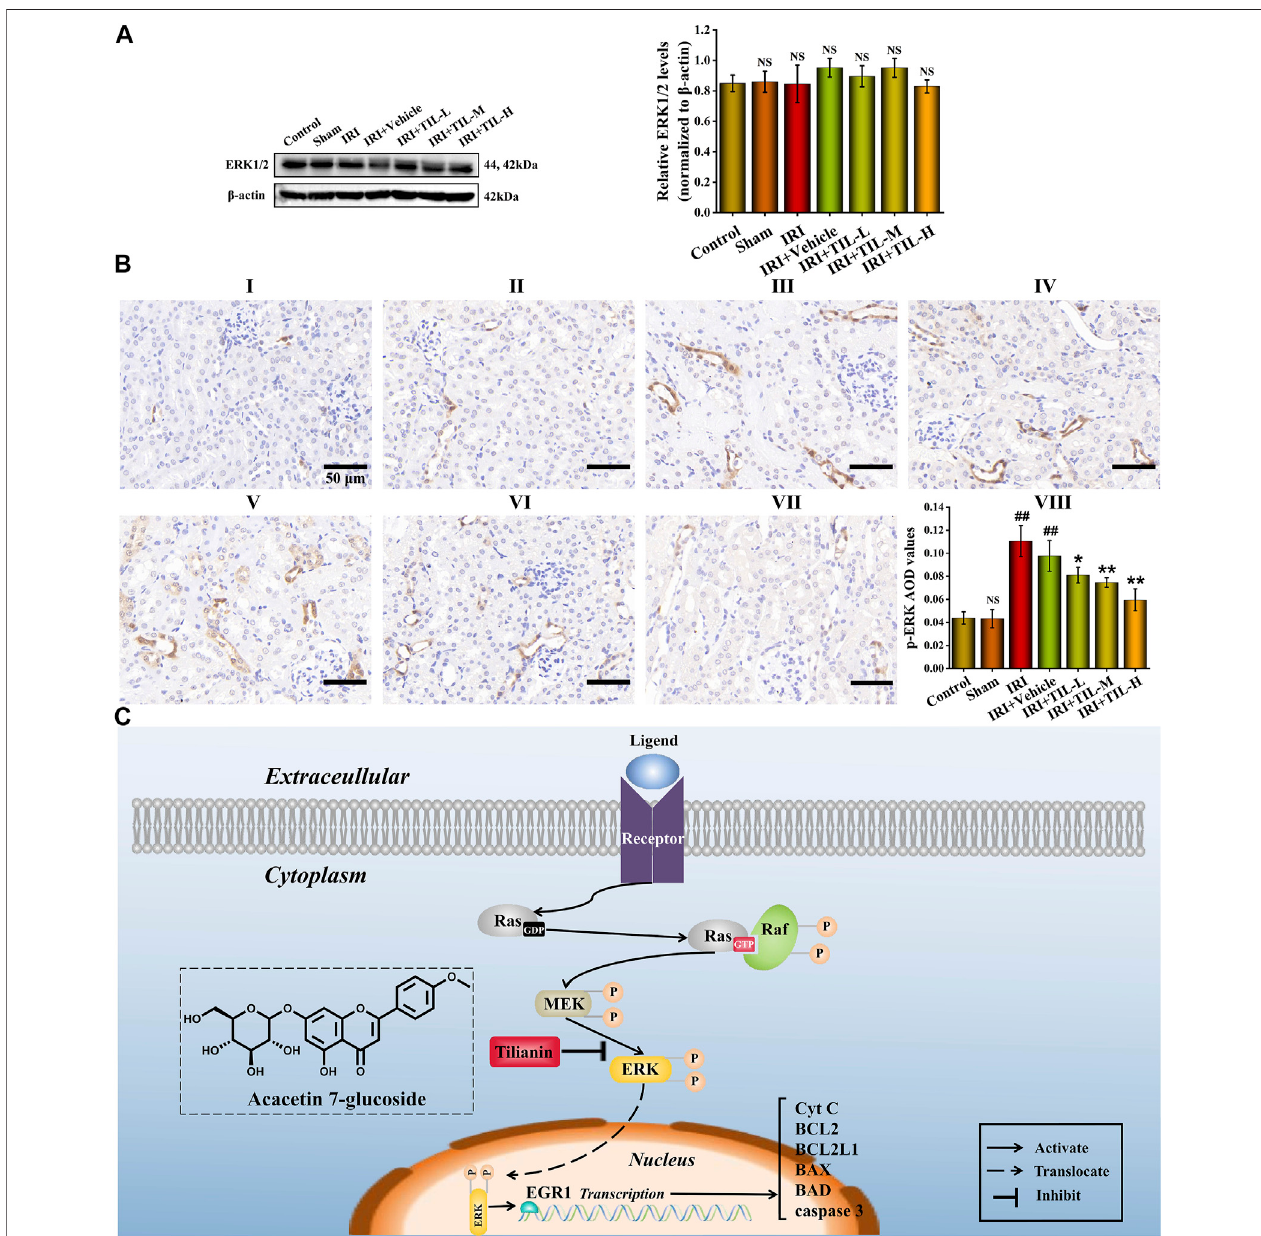
FIGURE 8 | Tilianin attenuated apoptosis after I/R-induced AKI via the ERK/EGR1/BCL2L1 pathway. (A) Protein expression and statistical results of ERK1/2 in different groups, as indicated. n = 3 per group. (B) Immunohistochemistry images of p-ERK under the magni fi cations of 400× show the location and quanti fi cation of p-ERK inthemousekidneyafter I/R-induced AKI.Scalebar,50 μ m( Ⅰ :controlgroup; Ⅱ :shamgroup; Ⅲ :IRIgroup; Ⅳ :IRI+vehiclegroup; Ⅴ :IRI+TIL-Lgroup; Ⅵ :IRI+TIL- Mgroup; Ⅶ :IRI+TIL-Hgroup;and Ⅷ :statisticalresultsofp-ERKAODvalues). (C) Schematic fi gureillustratedthatonceRTECssufferedfromexternalstimulation, the ERK pathway was activated, resulting in increased phosphorylation of ERK1/2 and its translocation. Tilianin alleviated apoptosis after I/R-induced AKI via reducing thephosphorylationlevelofERK1/2andtranscriptionalactivationofEGR1.Alldataareshownasmean±SD. ## p < 0.01 versus control ; NS P > 0.05 versus controlorIRI ; *p < 0.05, **p < 0.01 versus